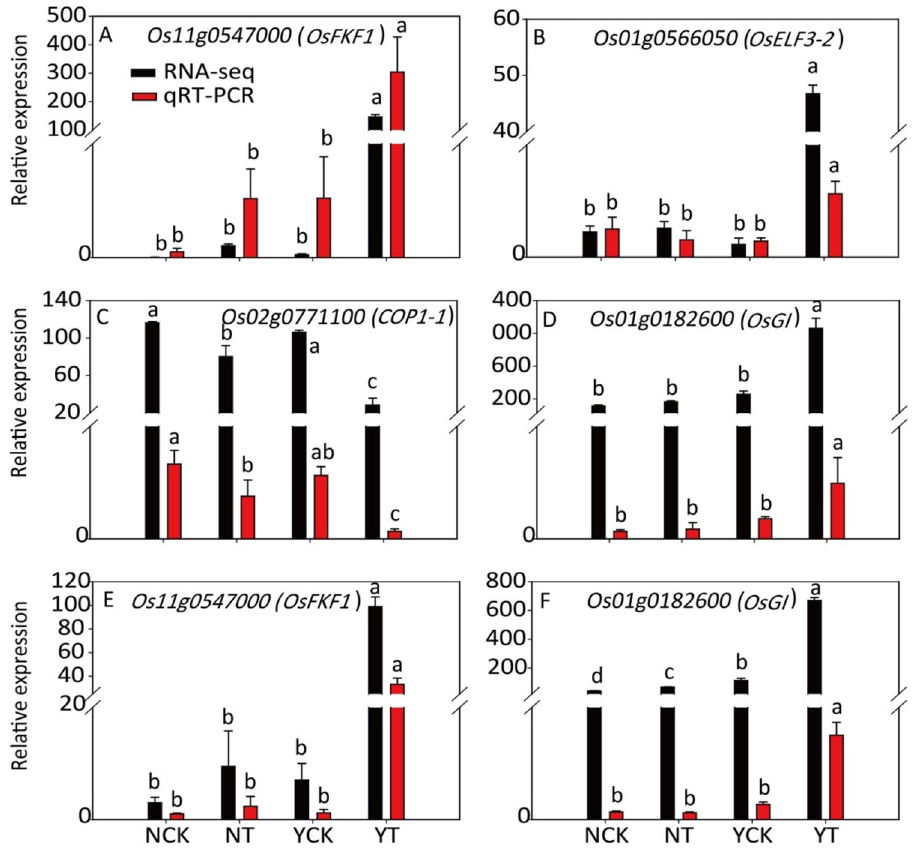
Figure 5. The relative expression of DEGs in the leaves ( A – D ) and panicles ( E , F ) of Ninggeng 4 and Yongyou 538 sown on two sowing dates. This figure was created using Origin 2021 and Adobe Illustraor CS6. Values are the means and sds. Means followed by different letters in the same test method are significantly different according to Tukey’s HSD test ( P <